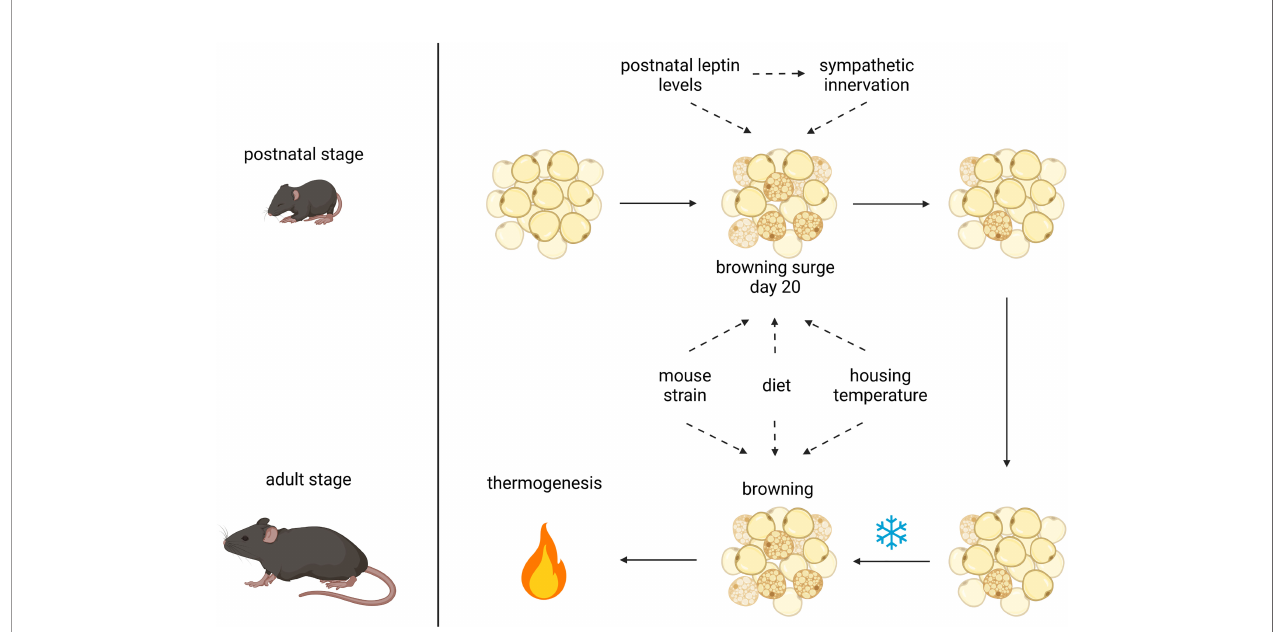
FIGURE 1 | Postnatal and adult adipose tissue remodeling and its possible in fl uencing factors. Browning of white adipose tissue after birth may be affected by leptin levels, sympathetic innervation, mouse strain, maternal diet and housing temperature. The latter 3 factors also have an impact on browning of WAT in the adult animal upon cold stimulation to induce thermogenesis, possibly in concert with postnatally acquired capabilities; created with